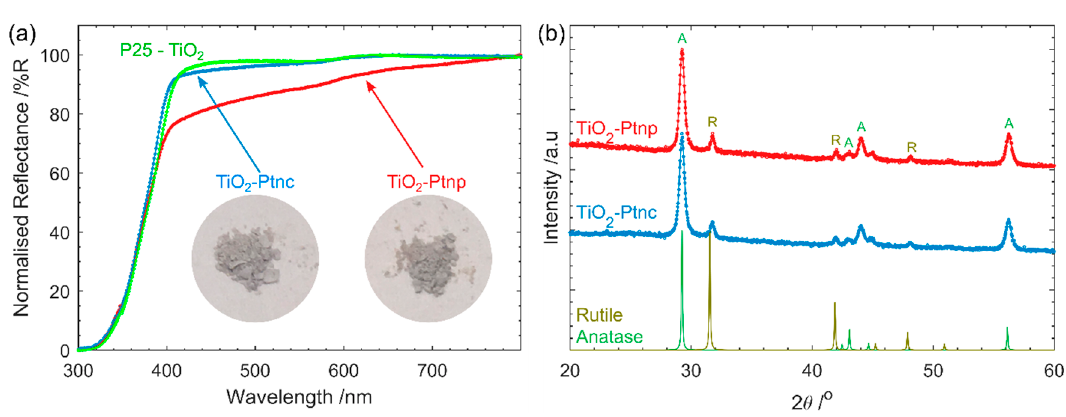
Figure 4. Optical and crystallography properties of the samples produced showing ( a ) ultraviolet-visible (UV-vis) reflectance of the powdered samples (inset shows digital photographs) and ( b ) X-ray diffraction (XRD) patterns of P25 (TiO 2 ) bare and with Pt nanoparticles and nanoclusters. Co irradiation source, λ = 1.78896 nm. Anatase (mp-390, I4 1 /mnd) and rutile (mp-2657, P4 2 /mnm) diffraction patterns calculated from crystallographic information files obtained from the materialsproject.org.